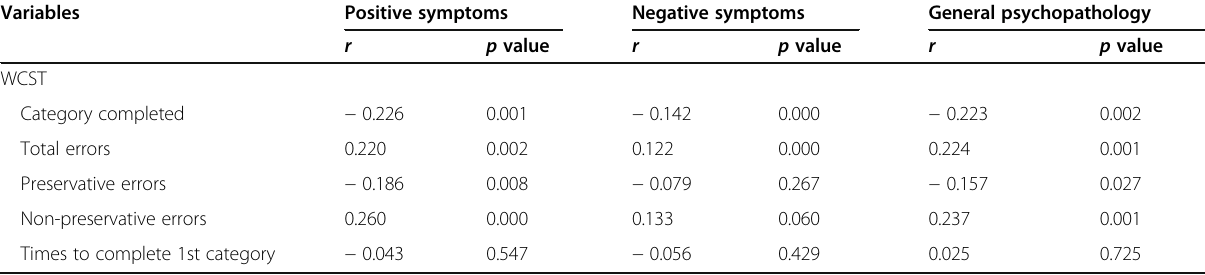
Table 4 Correlation between executive functions and schizophrenia symptom severity Variables Positive